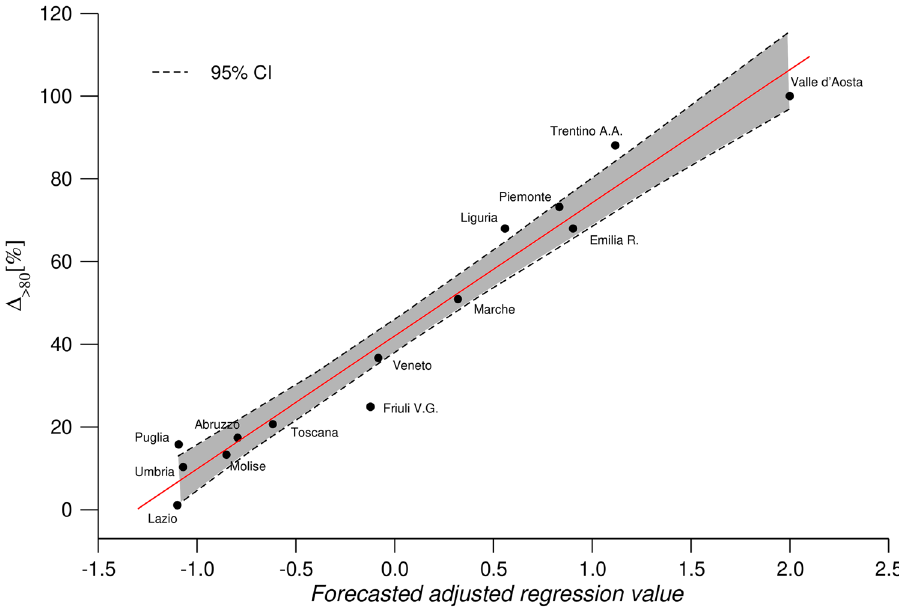
Figure 4. Deaths increase in aged > 80 population, adjusted for the number of death attributed to COVID-19 2 and for the LTCFs beds rate (adjusted R : 0.952, Stat. Sig.